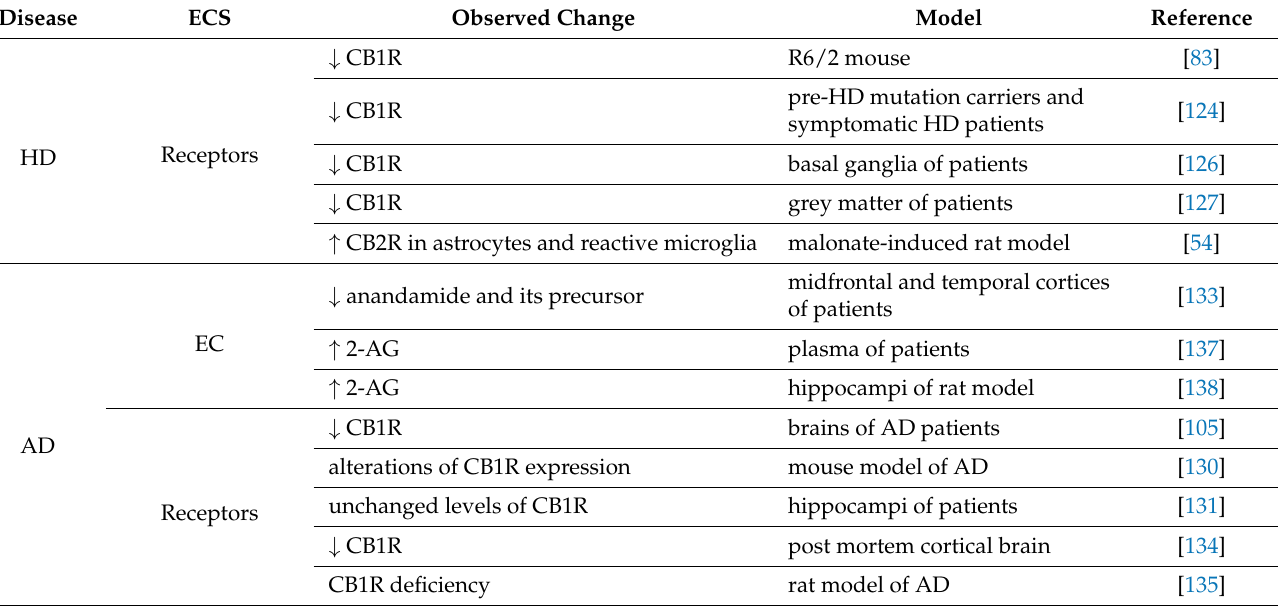
Table 1. Endocannabinoid system (ECS) in neurodegenerative diseases. Disease